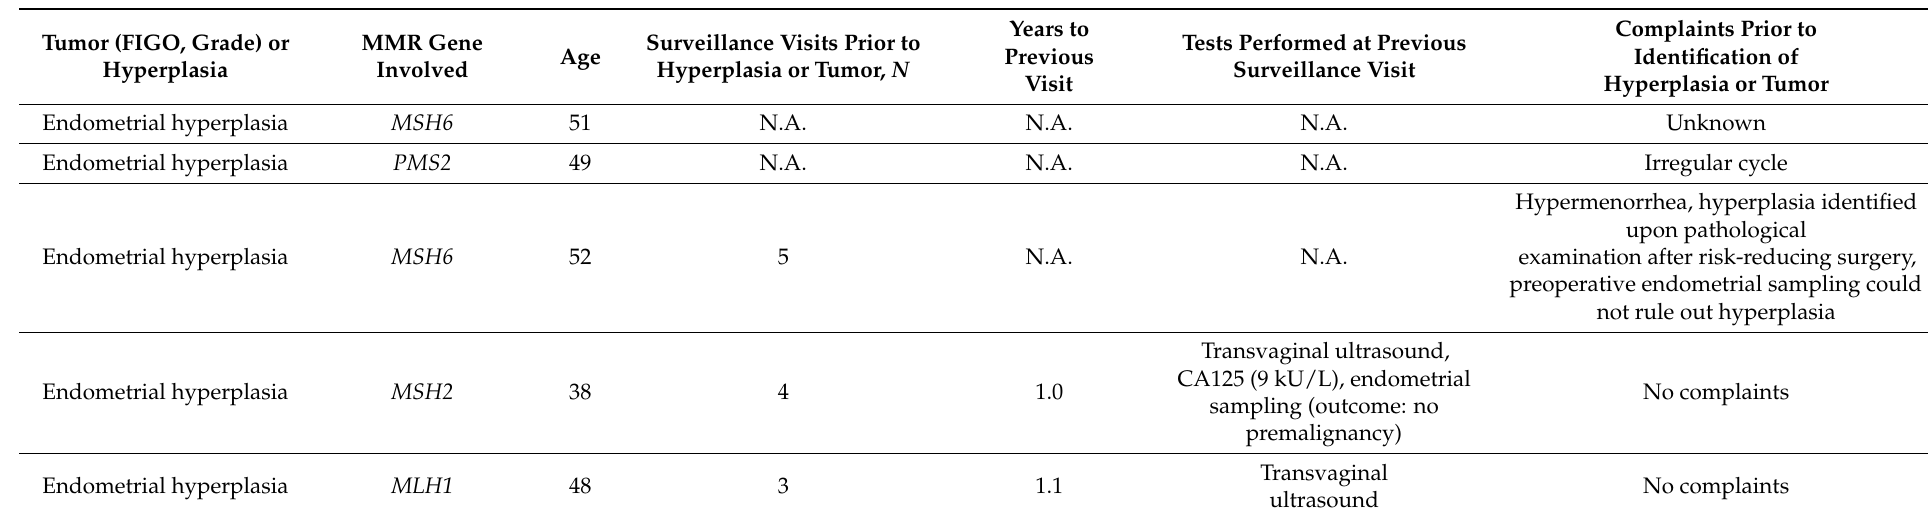
Table 3. Gynecological hyperplasia and malignancies identified during